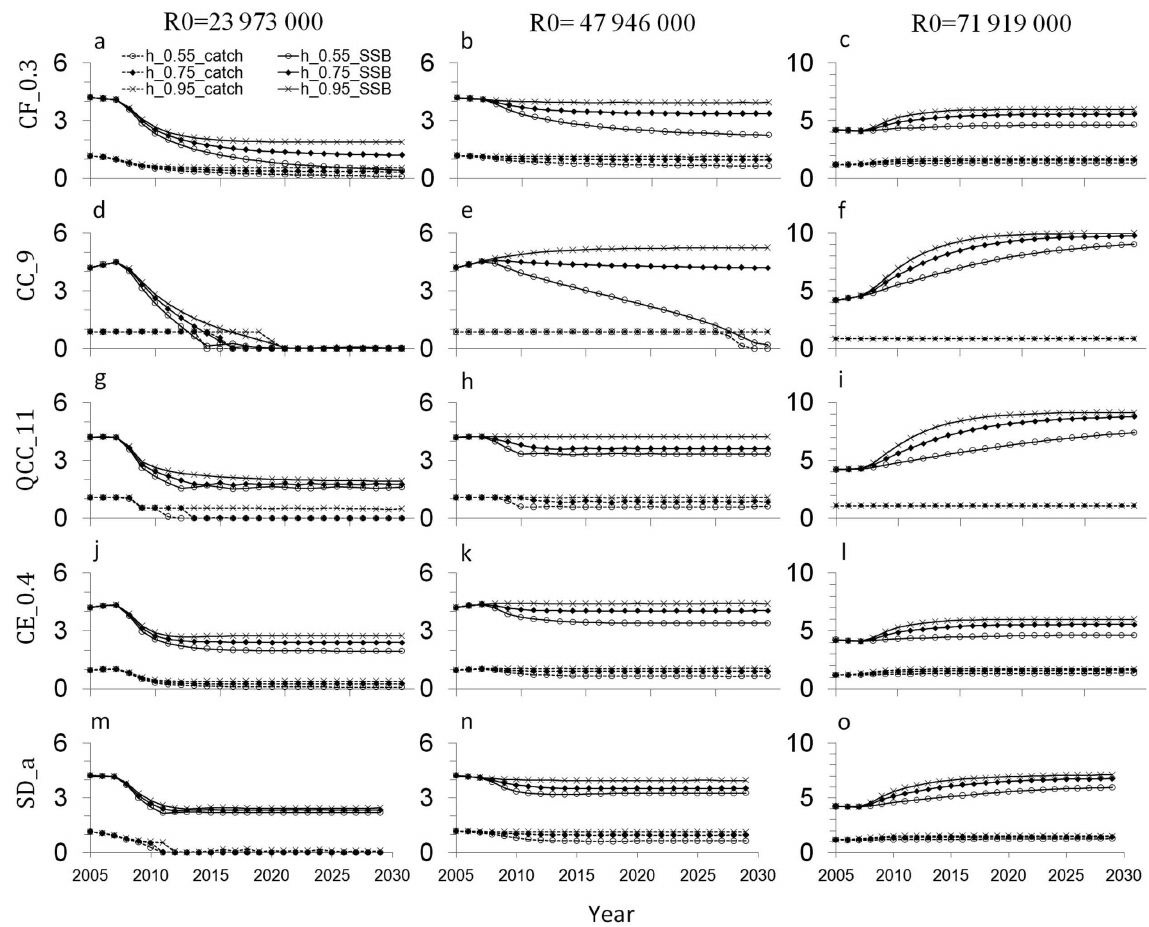
Fig . 5. – Temporal trajectories of catch (dashed lines) and SSB (solid lines) of five management strategy scenarios with different levels of virgin recruitment and steepness parameter in the Beventon-Holt stock recruitment